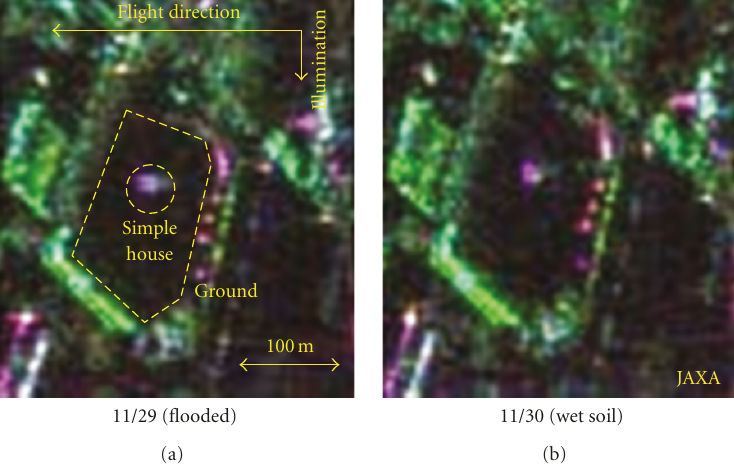
Figure 2: PiSAR L-band images on 2007 November 27 (left), 29 (middle), and 30 (right). Red: HH; green: HV; blue: VV.